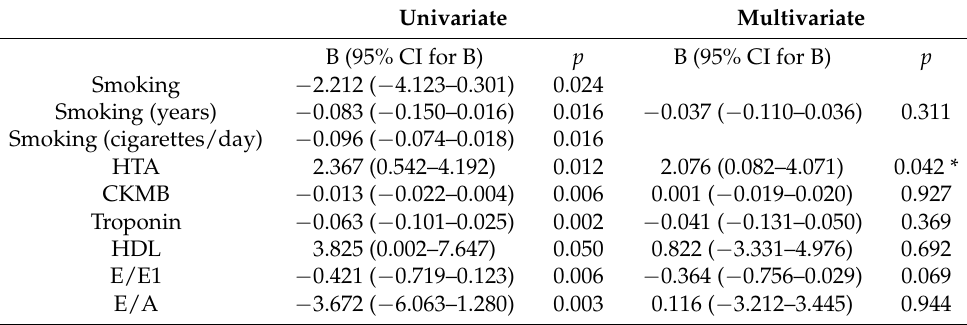
Table 6. Univariate and multivariate regression analysis demonstrating the relationship between baseline characteristics and galectin-3 concentration on day 5 for the entire population.